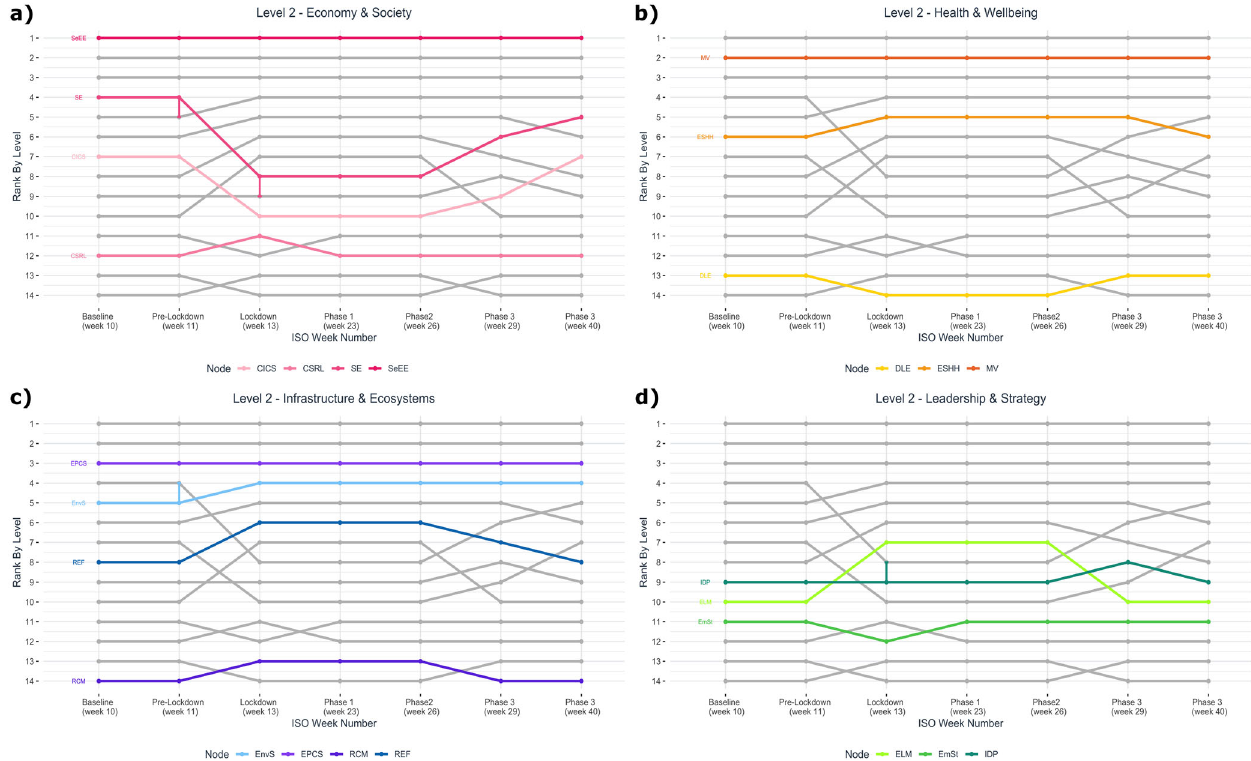
Fig. 6 Rank changes in outcomes at key phases changes throughout the modelled period, by category (rank con fi dence included – see “ Methods ” section). Rank changes in the a economy & society category, b health & wellbeing category, c infrastructure & ecosystems category, d leadership & strategy category (for full node names behind abbreviations see Fig. 5 or Table